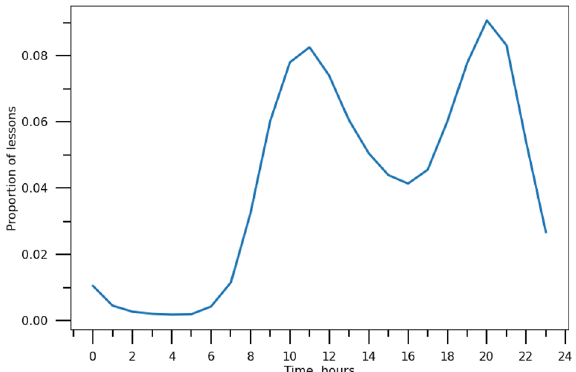
Figure 4. Hourly changes in the proportion of lessons. Skyeng lesson intensity displayed peaks in the morning (10:00 to 13:00) and evening (19:00 to 22:00). The minimal activity level corresponds to the night period (01:00 to